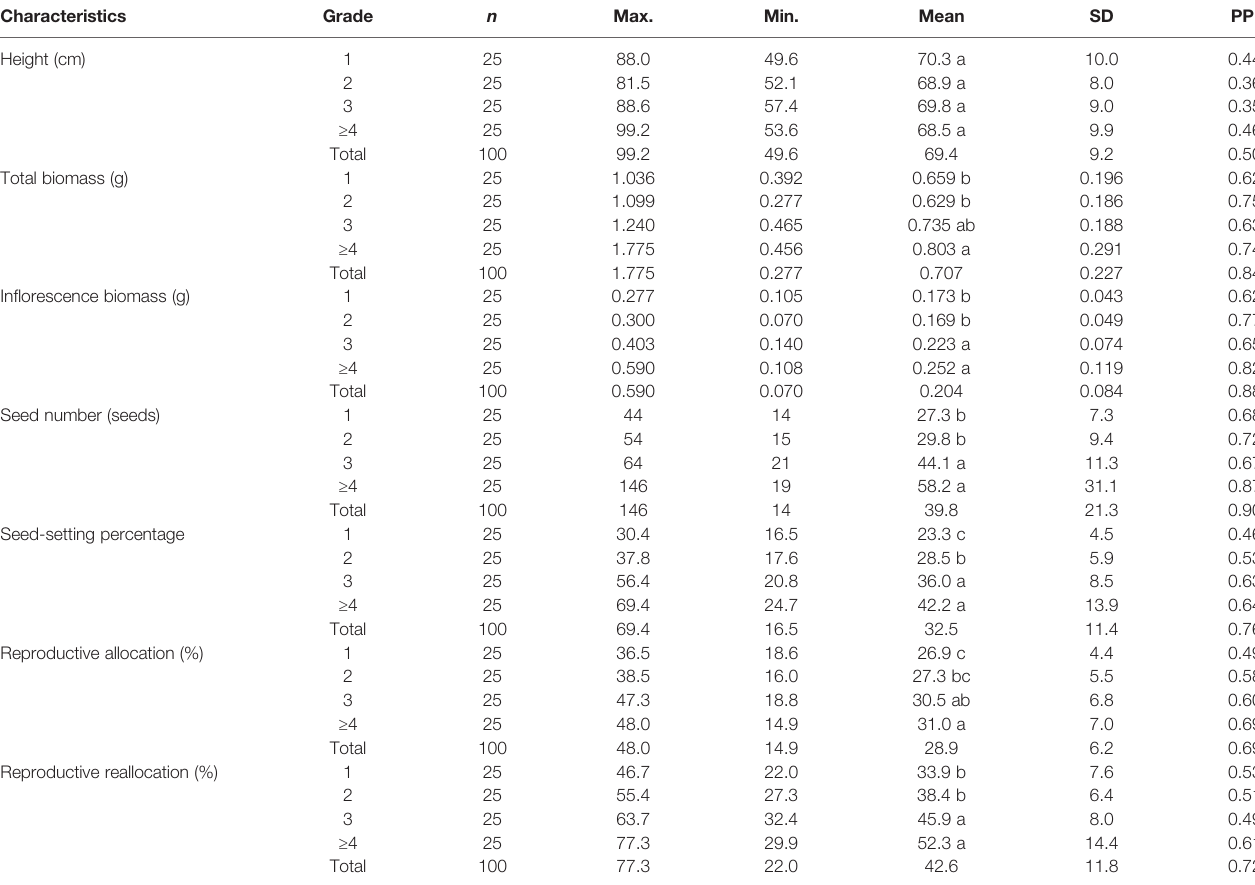
TABLE 2 | Phenotypic characteristics of the reproductive ramets connected with different number grades of vegetative ramets by tillering nodes in the Leymus chinensis population (sample size, n ). Characteristics Grade n Max. Height